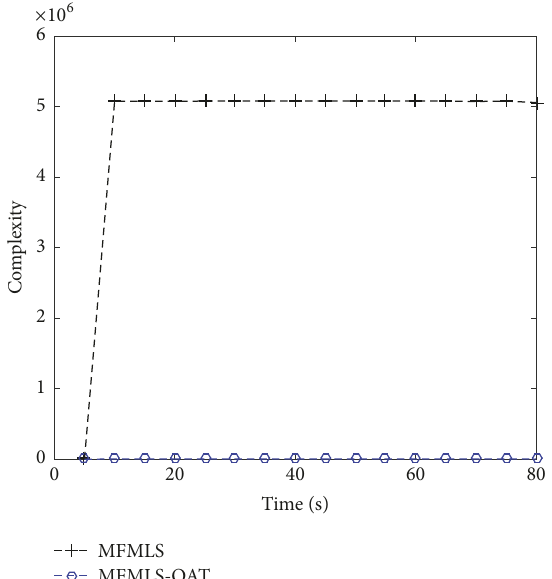
Figure 6: Computational complexity by different algorithms with low MSE thresholds.